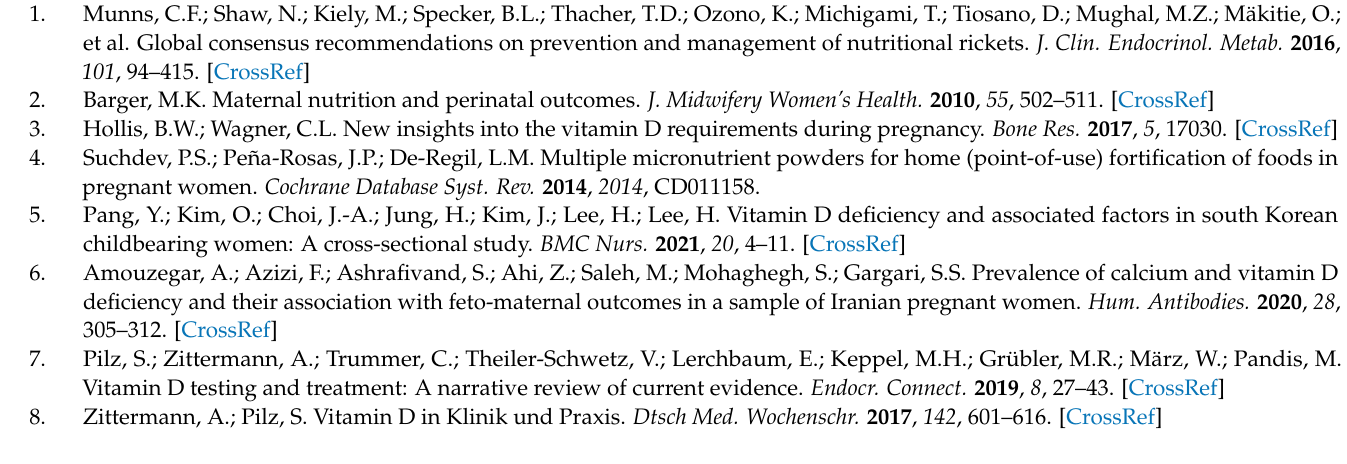
Table S3. Prevalence and factors associated with Ca deficiency in Brazilian pregnant or non-pregnant women of childbearing